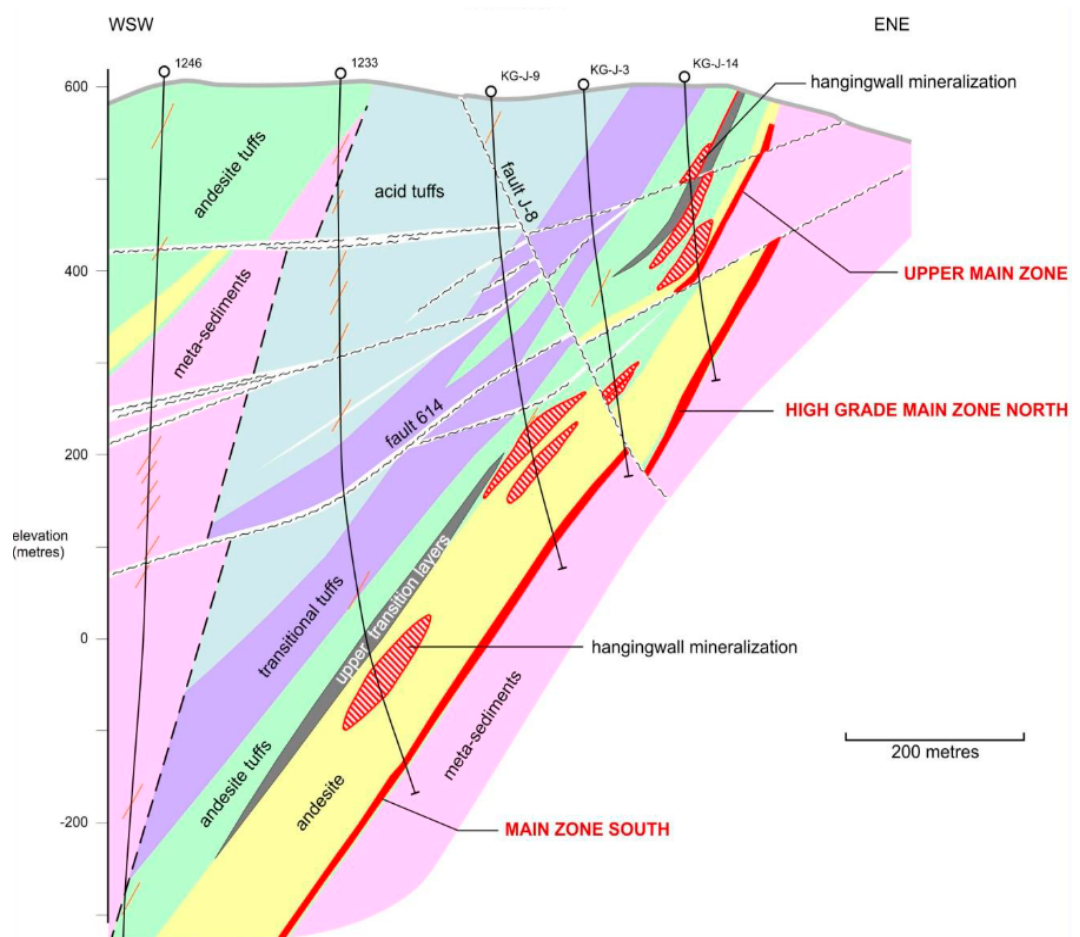
Figure 2. The geological section of the deposit of Kuriskova [58]. Table 3. The reserves level of the deposit of Kuriskova